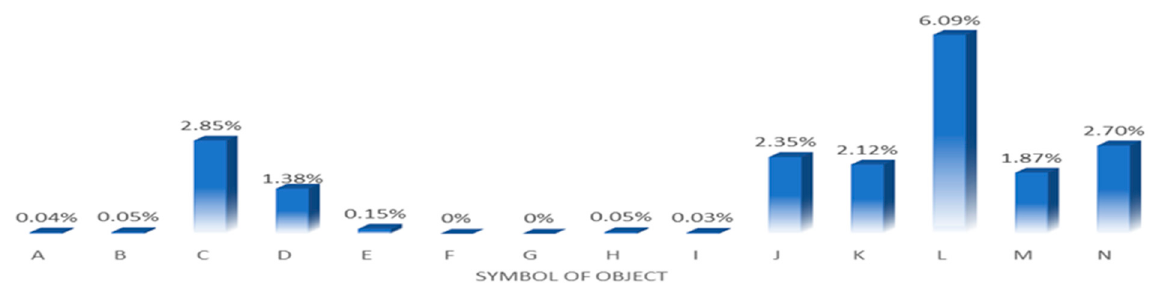
Figure 5. Average absolute change of a plot area. Source: own study.